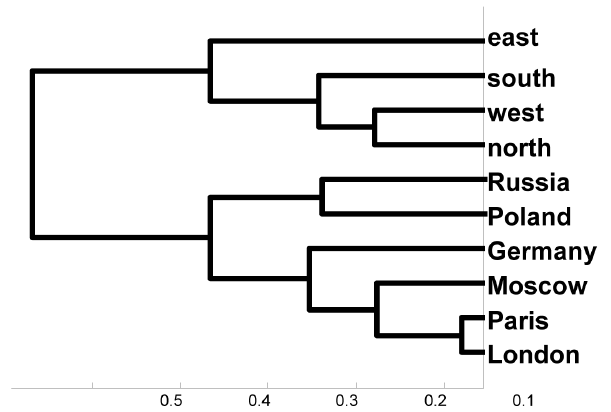
Figure 16. Significant structural similarities (partial orders of similarity differences invariant between the brain data and the linguistic data) for the set of words { London, Moscow, Paris, north,south,east,west,Germany,Poland,Russia } from 60 single- trial classifications for each participant.